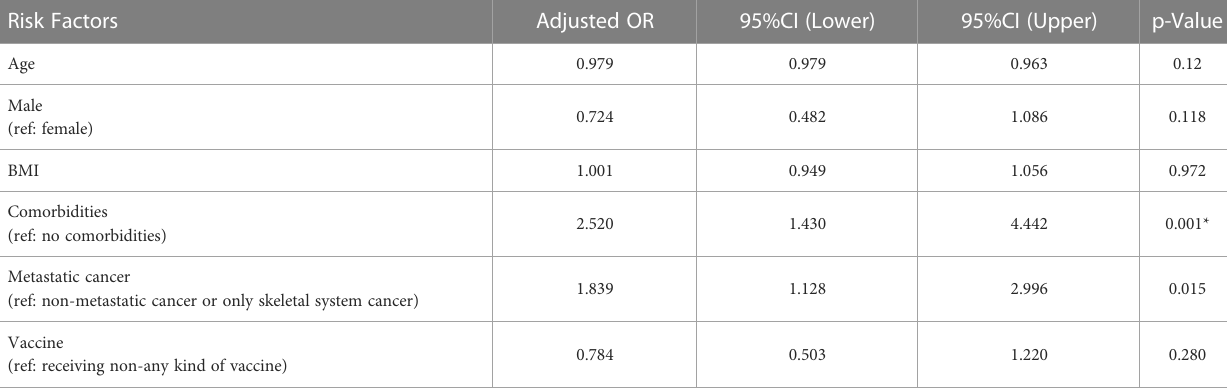
TABLE 5 Risk of total any grade adverse events (n =